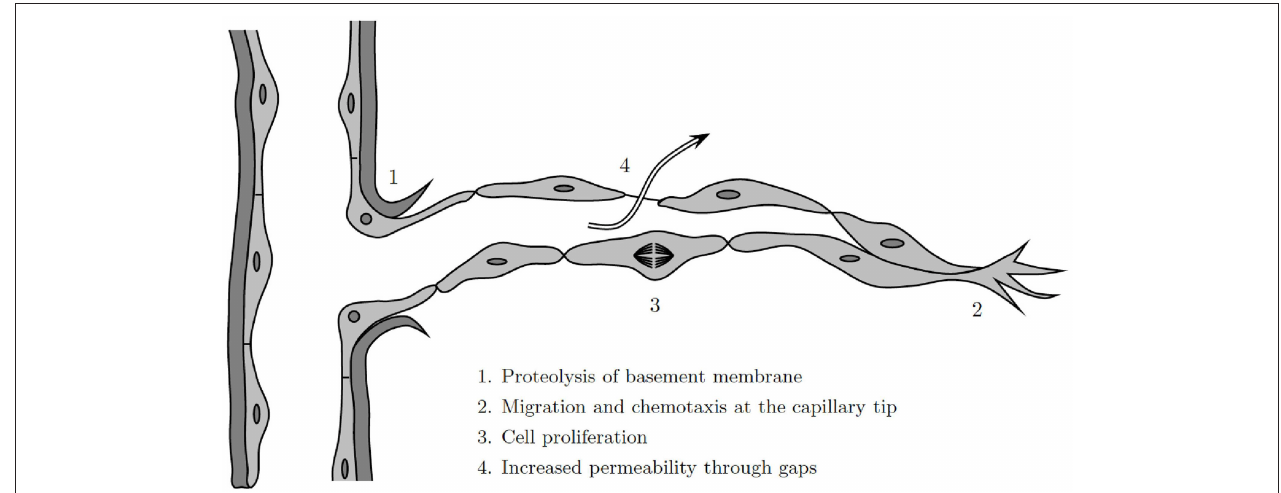
FIGURE 5 | Illustration of the angiogenesis process at a discrete cell level, modified from Cotran et al. (1999).